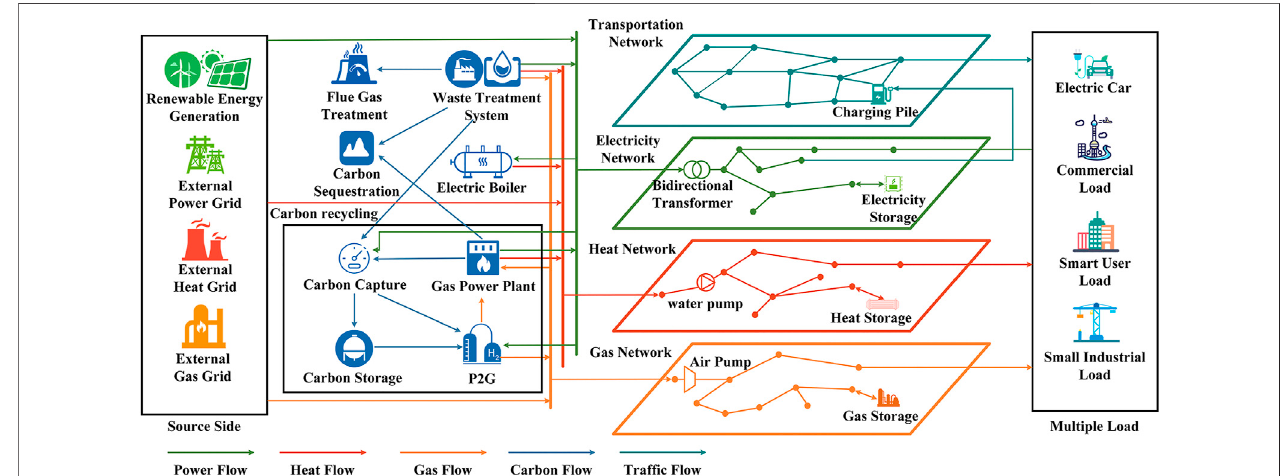
FIGURE 1 | “ Nearly-zero carbon park ” topology